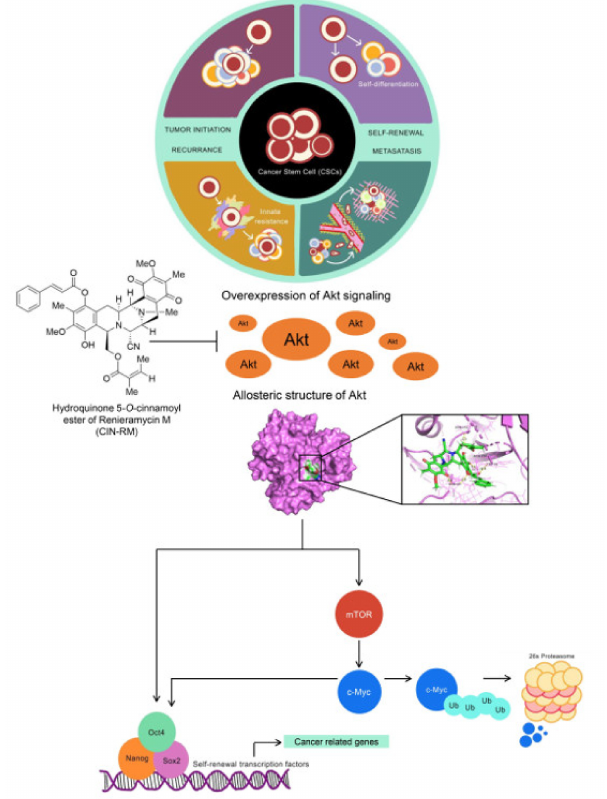
Figure 8. The proposed regulatory pathway is involved in the CSC suppression of CIN-RM. CSCs are the major cause of therapeutic failure due to their ability to self-renew and tumor initiation. They take part in cancer recurrence and metastasis. Akt signaling and related pathways are upregulated in CSCs leading to cancer aggressiveness. CIN-RM could directly interact and inhibit Akt function, resulting in the reduction of stem cell transcription factors. In addition, the inhibition of Akt triggers c-Myc proteasomal degradation. In the absence of upstream pluripotency factors Nanog, Oct4, and Sox2 and the protein co-factor c-Myc, the CSCs were